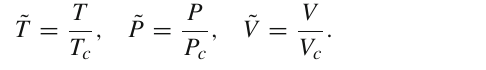
BHs cannot be distinguished above the critical point [52,53]. The plot pressure vs volume by utilizing the Eq. (23) in Fig. 2 shows the behaviour like the VdW gas/fluids model. The left and right figures correspond to the case of fixed elec- tric e = 0 . 2 and magnetic charges g = 0 . 6, respectively. The critical temperature curve is depicted by the red dotted line. The lower dashed-dotted line corresponds to a small temper- ature T < T c , which divides the curve into three branches of BH, one unstable and two stable configurations. These two stable configurations have a positive compression coef- ficient ( P decreases as V increases). We also have an unstable region with a negative compression coefficient ( P increases as V increases) between these two regions at which the BH of intermediate size can represent the mixture of liquid